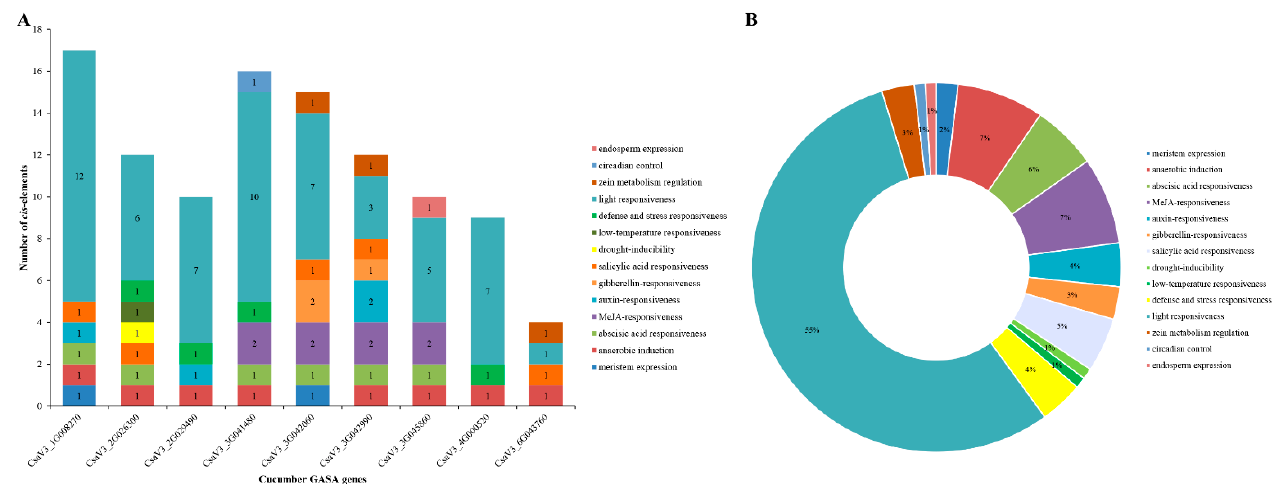
Figure 4. Cis -elements analysis of the promoters of cucumber GASA family genes. ( A ) The types and numbers of various cis -elements in the promoters of each cucumber GASA gene. ( B ) The relative proportions of different types of cis -elements in the promoters of cucumber GASA genes are displayed by doughnut chart.